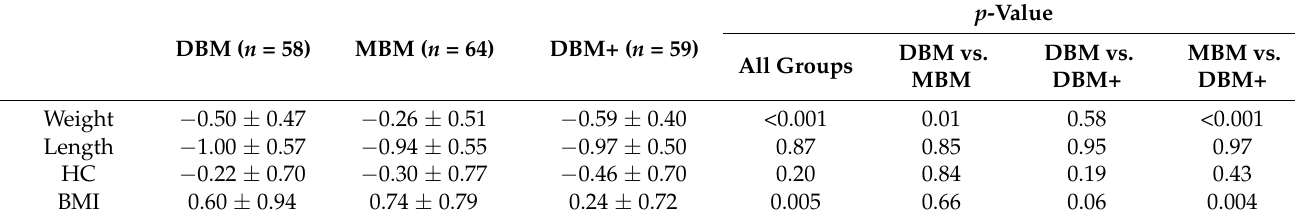
Table 5. Net change in growth measurement z-scores from birth to 36 weeks PMA.